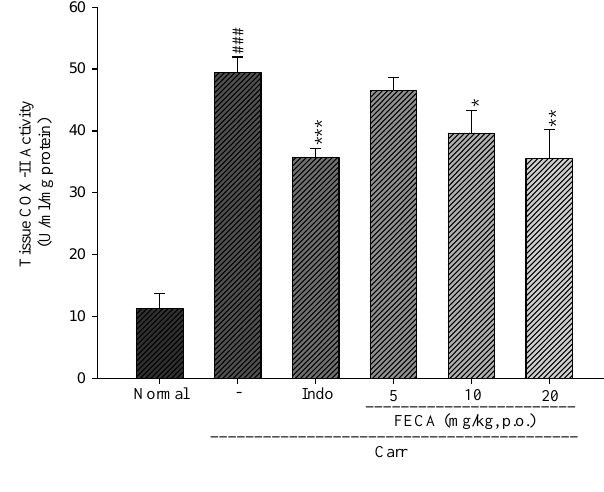
Figure 2. Effects of FECA and Indo on tissue COX-2 activity of edema paw in mice. Each value represents as mean ± S.E.M. ### p < 0.001 as compared with the normal group; * p < 0.05; ** p < 0.01; *** p < 0.001 as compared with the λ-carrageenan (Carr.) group (one-way ANOVA followed by Scheffe’s multiple range